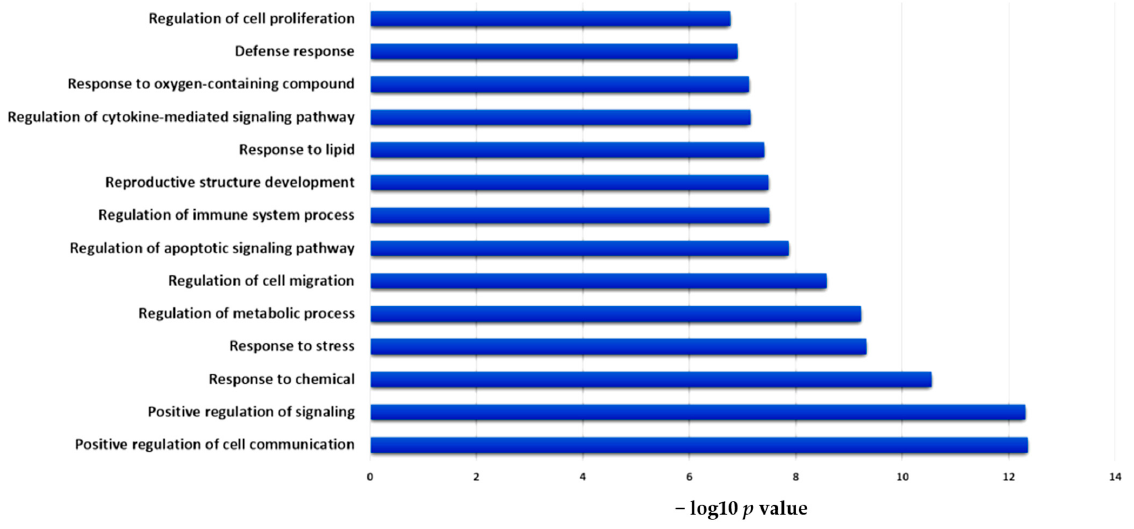
Figure 3. Functional annotation of significantly enriched GO categories of upregulated genes. Bar charts show the top 14 enriched Gene Ontology (GO) categories for post-irradiation biological processes. Table 1. The top 14 enriched Gene Ontology (GO) terms of the 25 post-irradiation upregulated genes. GO ID and